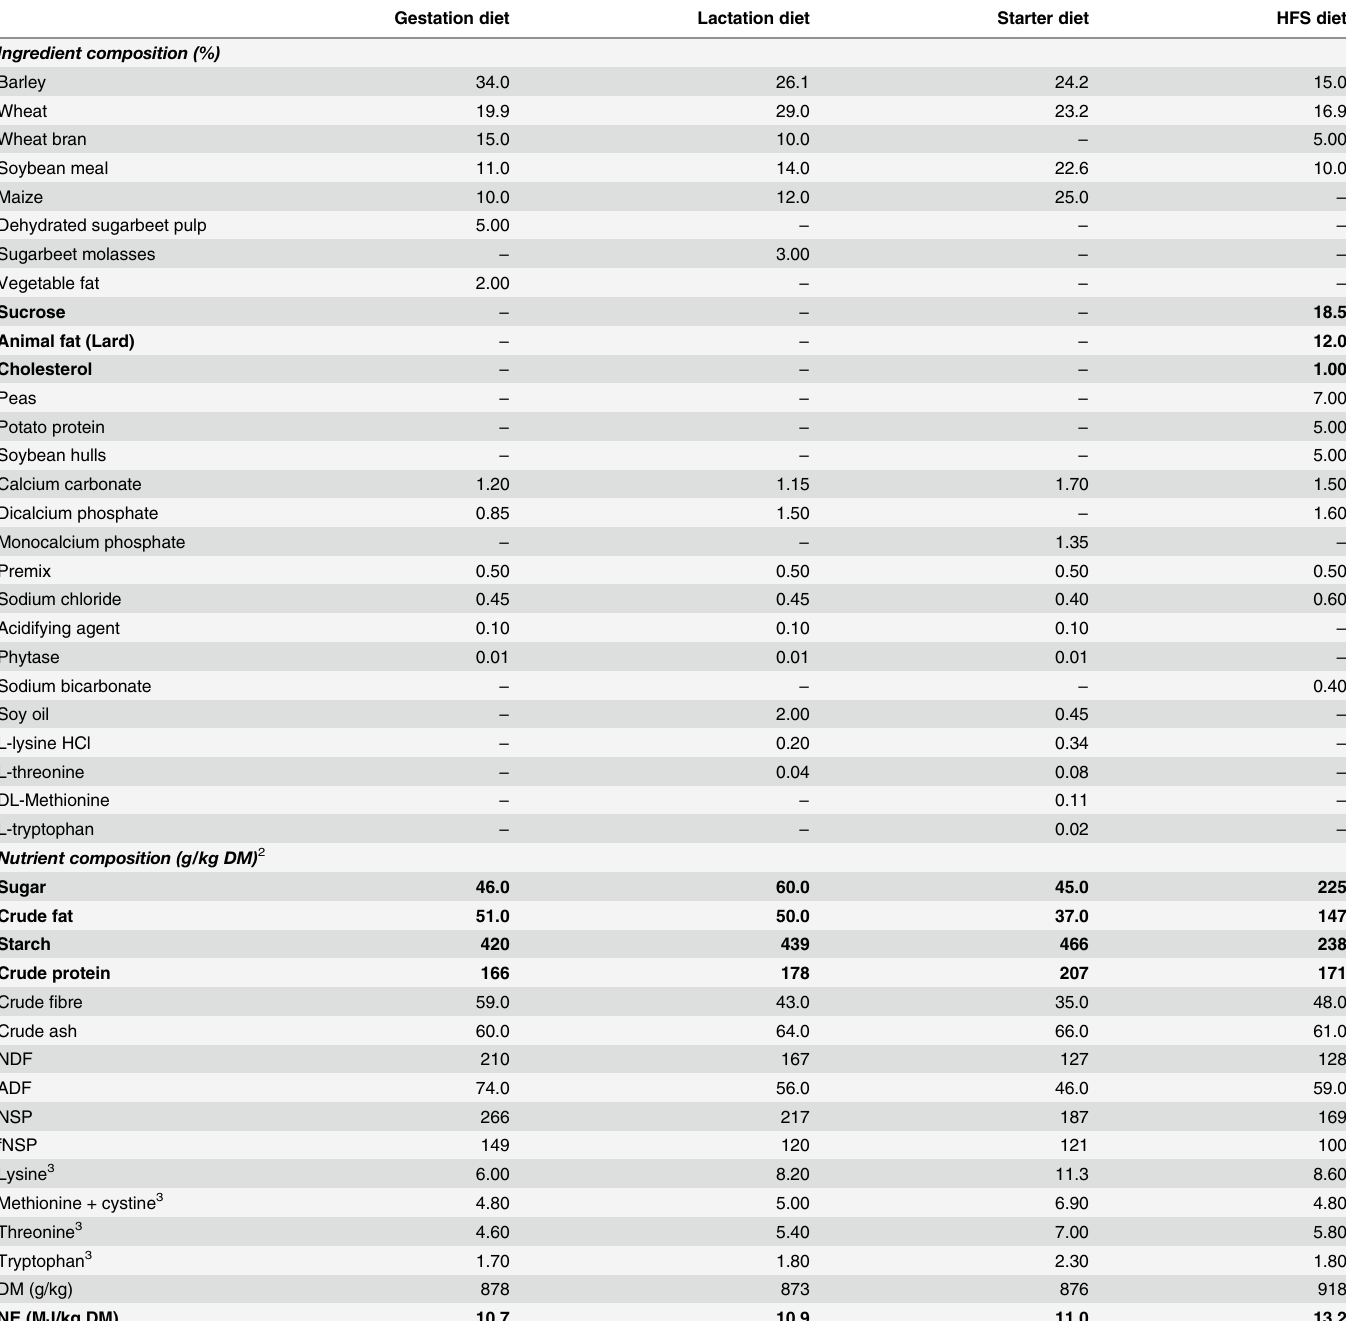
Table 1. Ingredient and nutrient composition of the experimental diets 1